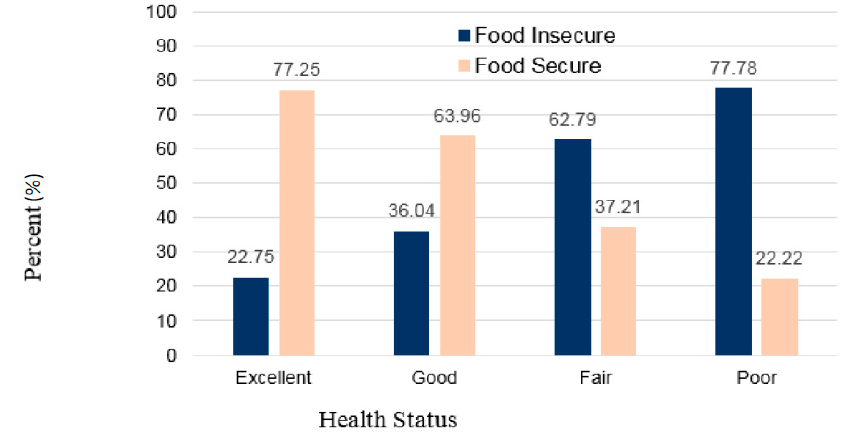
Figure 1. Percent of health status category by food security status among students. Association of